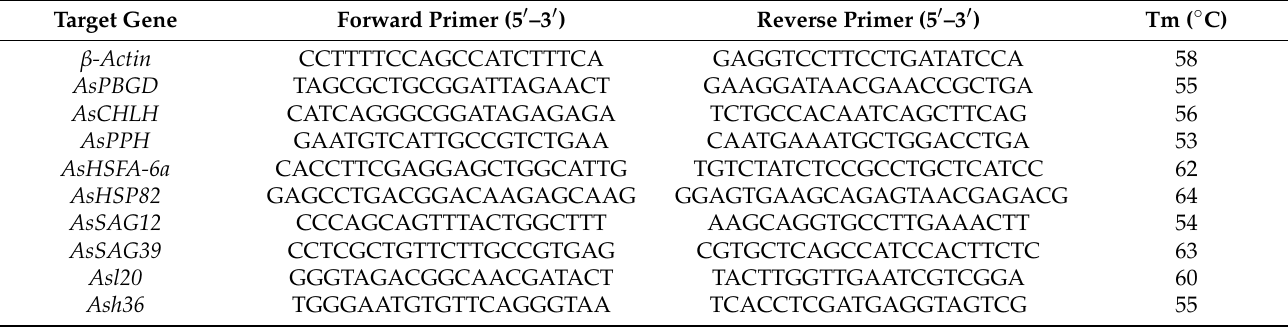
Table 1. Primer sequences and annealing temperature of the analyzed genes. Target